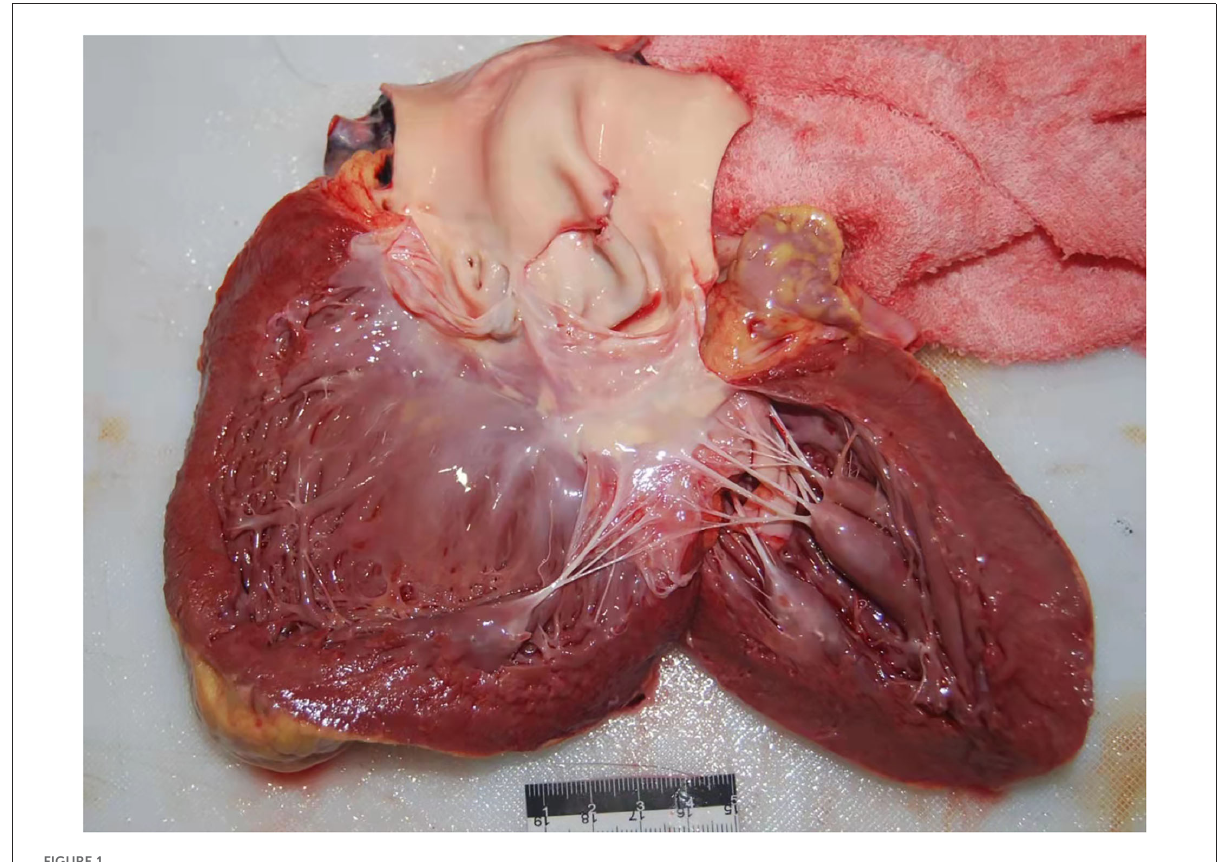
FIGURE1 Representative picture of bicuspid aortic